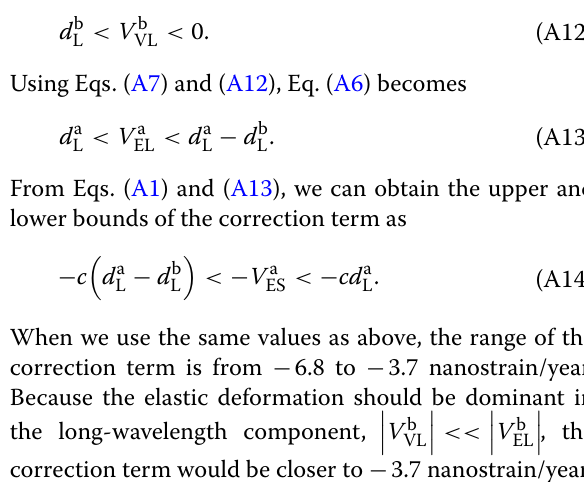
The long-wavelength components of observed geodetic d b d a data, L and L , correspond to the offset components, which were used to obtain the strain-rate profiles of Fig. 2 from the profiles of Fig. 1e, f. By taking the average of the d b offset components, we can have the estimates of L and d a L to be about − 62 and + 74 nanostrain/year, respec- tively. Then, with Eq. (A11) and c to be about 0.05, the range of the correction term for the plastic strain rate of the short-wavelength component is between 3.7 and 6.8 nanostrain/year. Considering that the 2011 Tohoku- oki earthquake completely changed the long-wavelength deformation from contraction to extension, elastic defor- mation would be dominant in the long-wavelength com- . Then, the correction term is closer to 6.8 nanostrain/year. As for the viscous strain rate of the short-wavelength V a − V a component, VS , the correction term is ES from the comparison between Eqs. (9) and (A3). A similar equa- tion to (A10) can be obtained as